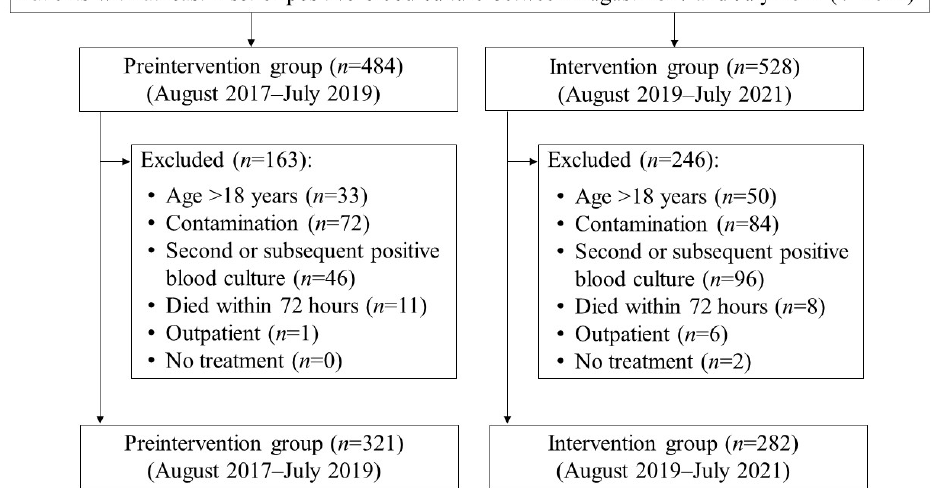
Figure 1. Flowchart of patient selection. Pharmacist-driven PAF was initiated in August 2019. The patients after this date are classified into the intervention group.